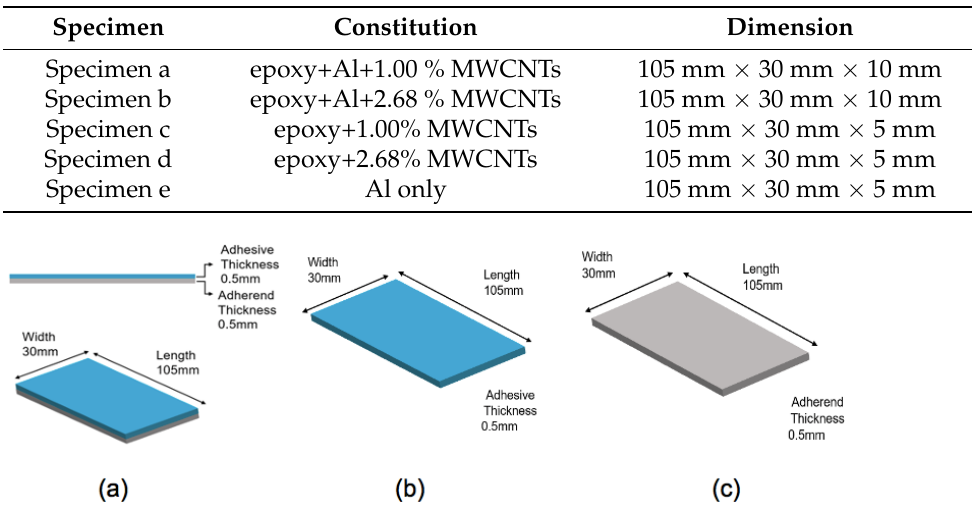
Figure 1. Schematics of specimens manufactured: ( a ) hybrid joint specimen; ( b ) epoxy specimen; and ( c ) aluminium specimen.